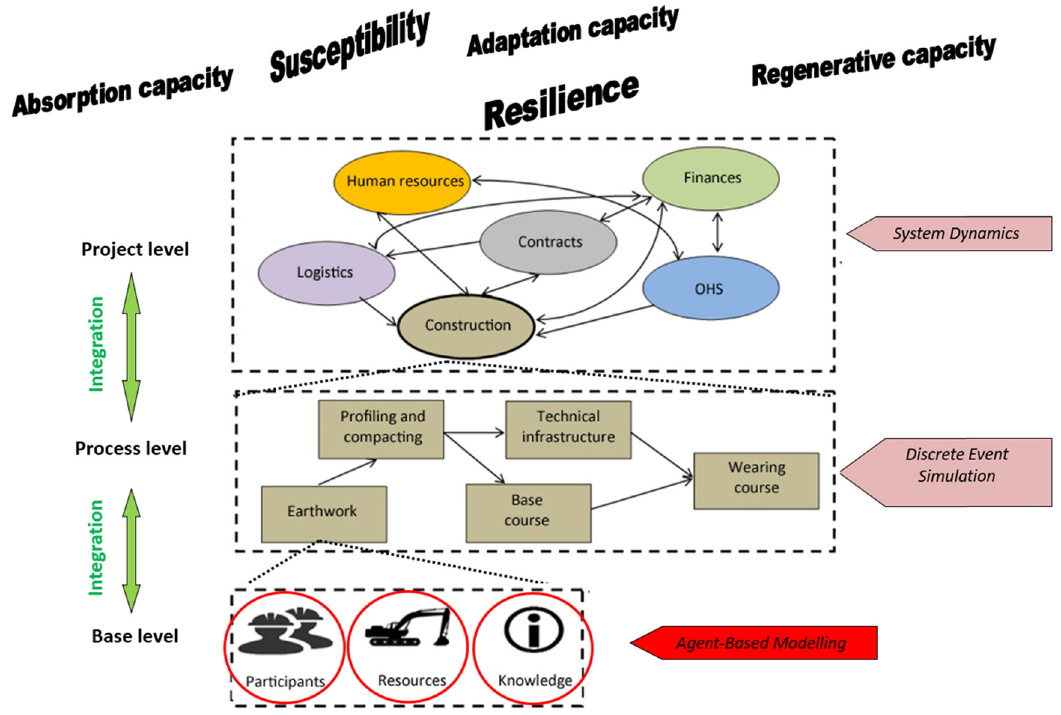
Figure 1: Conceptual representation of an SoS used for analysing construction project e ffi ciency. Source: original work based on refs [ 16,17 ]